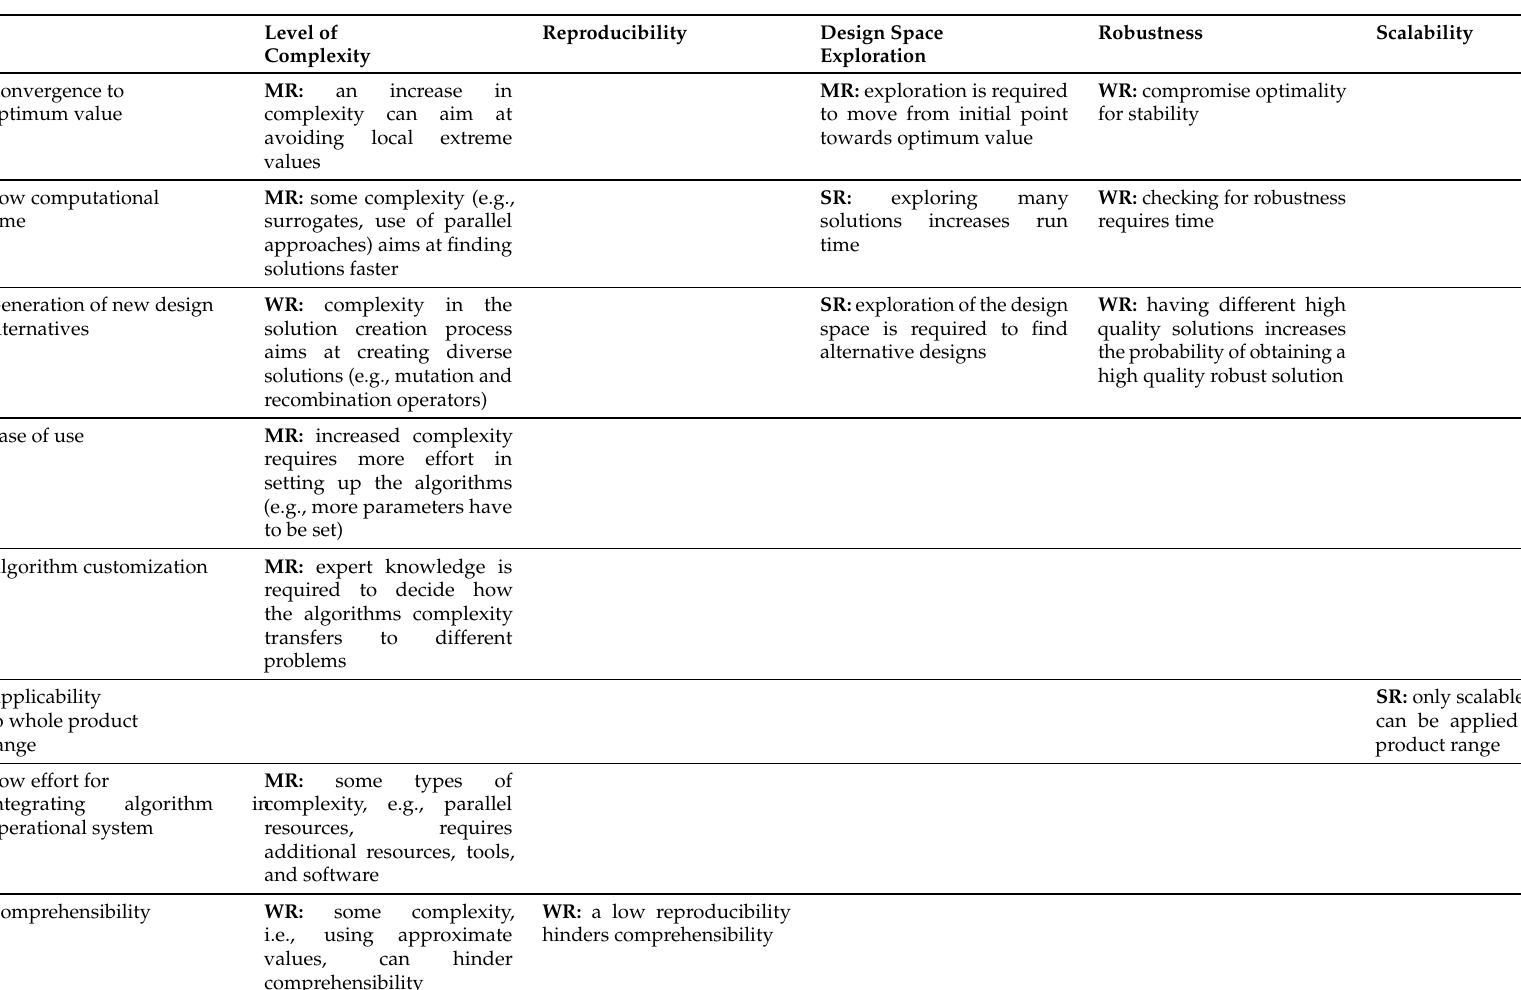
Table A4. Part 2 of relationships between end-user requirements and comparison criteria for the Decision Matrix. The used relationships are: SR , strong relationship; MR , moderate relationship; WR , weak